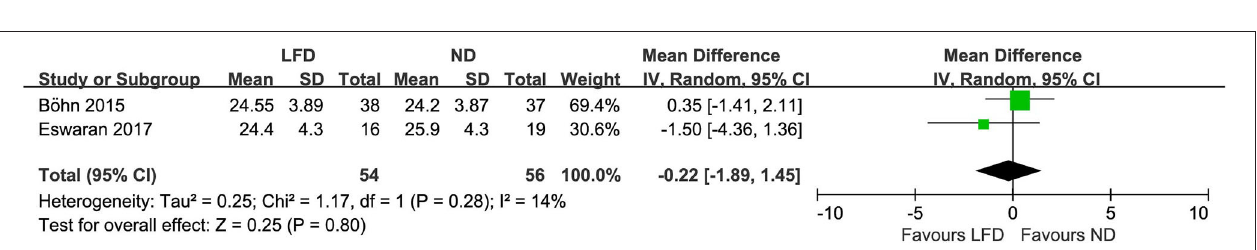
FIGURE 9 | Pooled mean difference for body mass index (BMI). LFD, low-FODMAP diet; ND, normal diet.